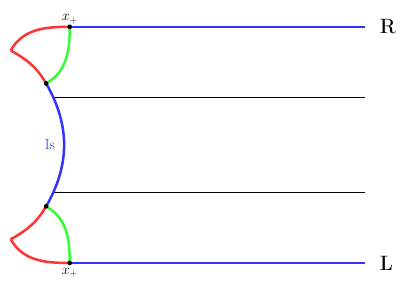
Figure 11 . The bulk picture is given for t t P . The time slice of the con(cid:12)guration is chosen as (cid:21) follows; except the island plus its bulk extension, which is in the constant (cid:28) slice, all the remaining regions are in constant t slice. The green-colored curves represent the bulk extremal curves and the blue curve denoted by \Is" stands for the island